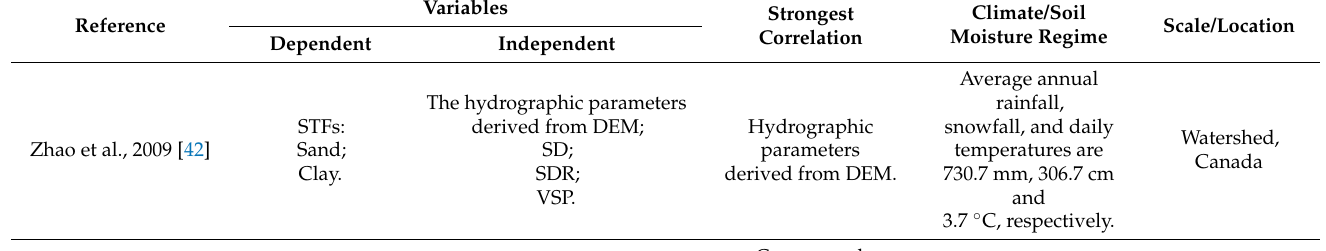
Table 1. Literature review on the use of covariates for soil texture fractions and soil texture class